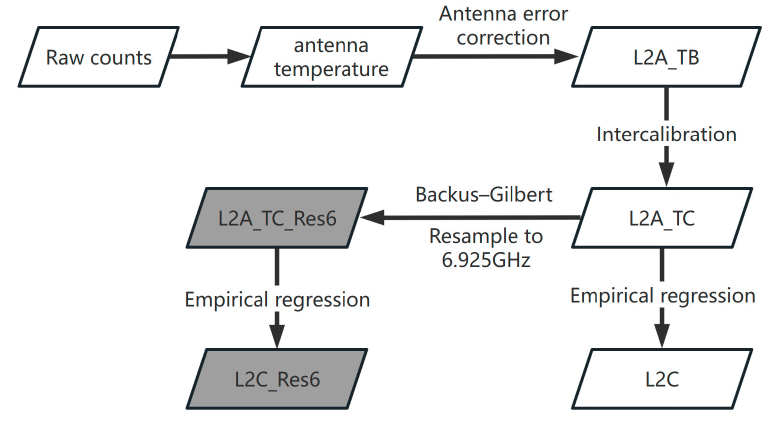
Figure 3. The flowchart of data processing for HY-2B SMR.